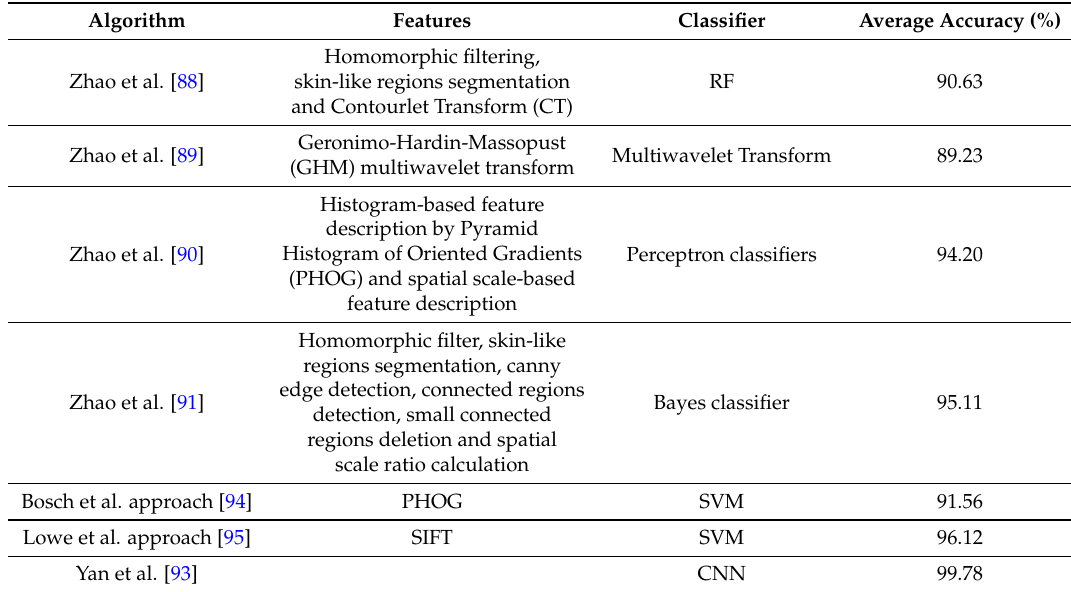
Table 2. Classification accuracy evaluated on the Southeast University (SEU) driving posture dataset [88].